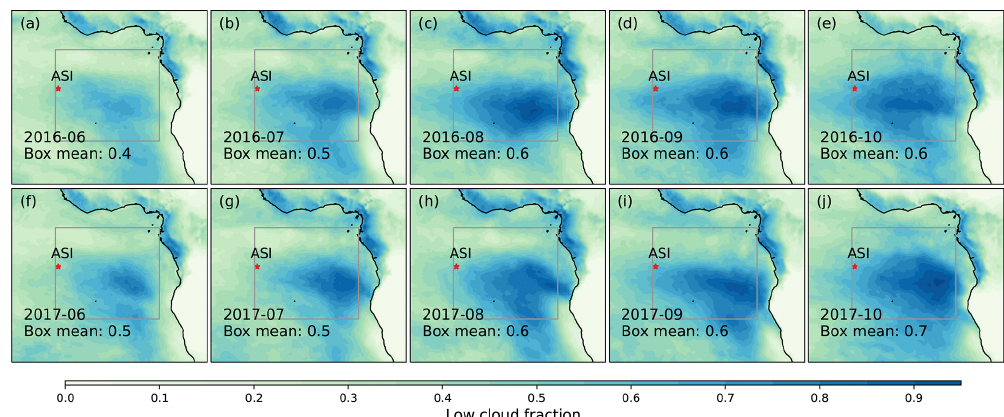
Figure 6. Monthly mean low cloud fraction calculated from the ERA5 reanalysis data. The location of ASI is marked with the red star. The grey boxes represent the range of the main transport paths of BB aerosols observed on ASI. The box means are the mean cloud fractions calculated in the grey box region.